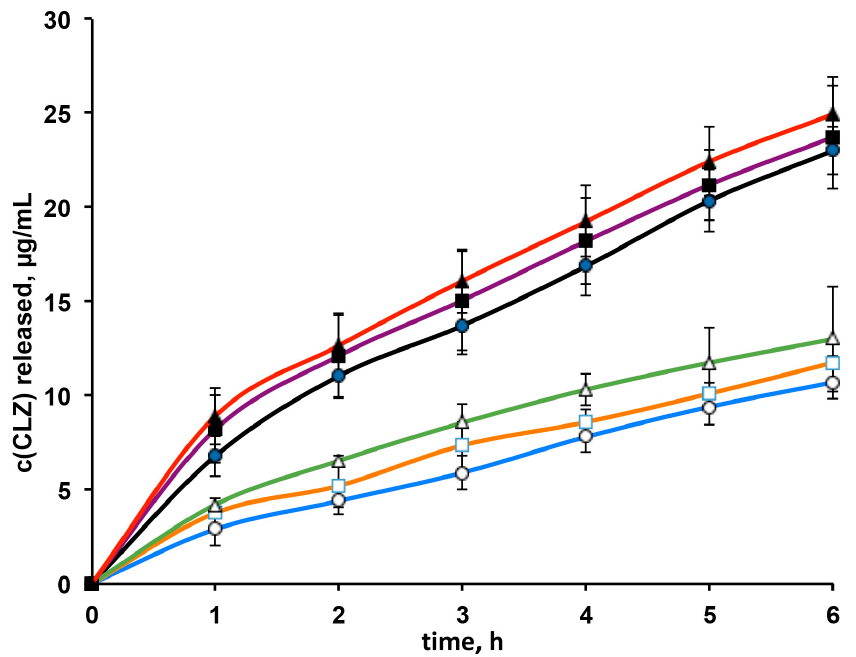
Figure 5. Release profiles of clonazepam (CLZ) from G1 ( • ), G3 ( (cid:4) ) and G5 ( (cid:78) ) gel formulations and from the corresponding ones without RAMEB (white symbols).